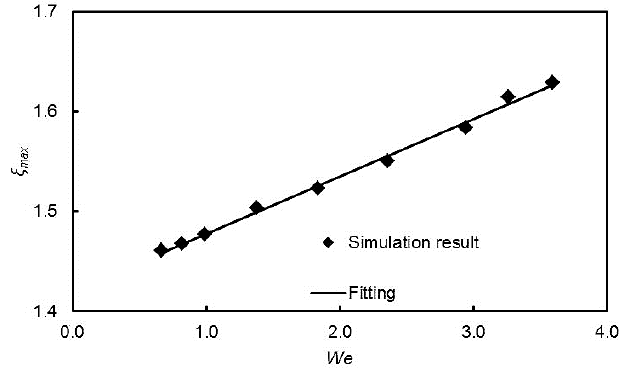
Figure 7. Maximum deformation ratio as a function of We under different impacting velocities.